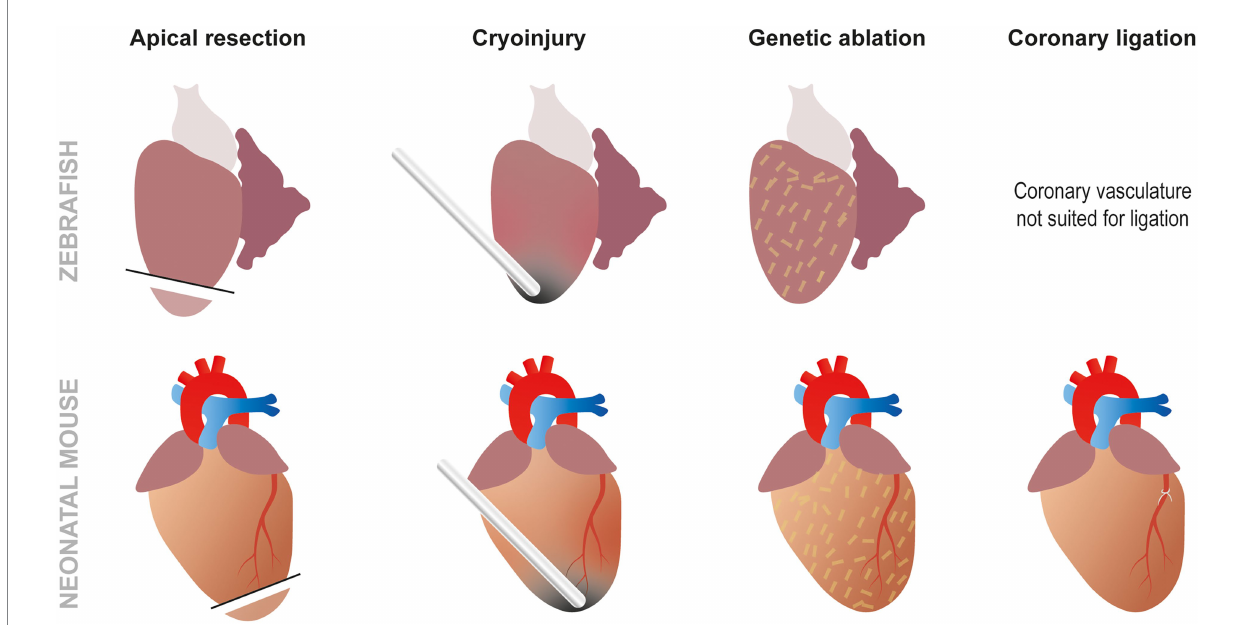
FIGURE 3 Approaches to study cardiac regeneration. While the most frequently used techniques to study zebrafish heart regeneration are apical resection and cryoinjury, it is also possible to induce genetic ablation using the NTR/Mtz or DTA systems. In neonatal mouse models, the same techniques can also be used but, unlike zebrafish, coronary ligation can also be performed to induced